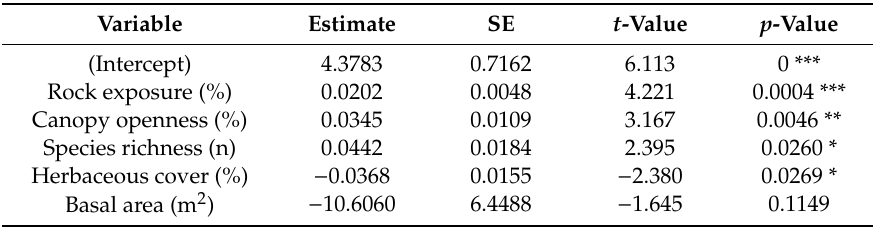
Table 3. Results of the multiple regression model for Abies nephrolepis seedling.